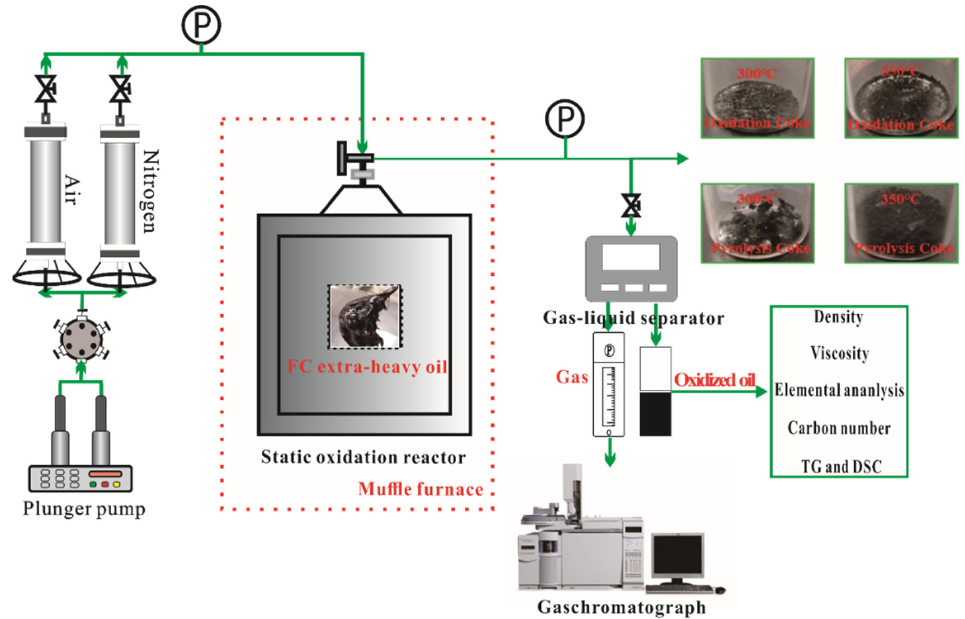
Figure 1. Simplified procedure of the isothermal oxidation experimental setup [27].